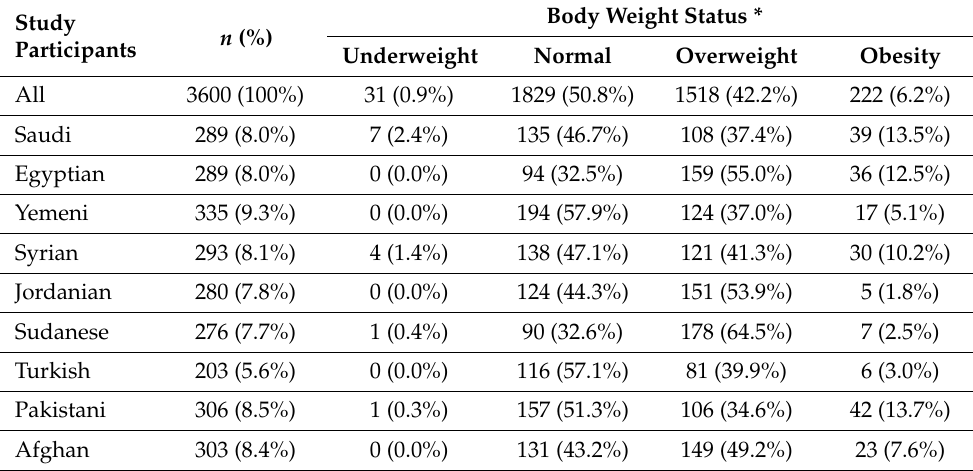
Figure 1. Bar chart illustrating mean body mass index for study participants from different countries. Bars labeled with different letters represent significantly different means ( p < 0.05) based on the Tukey post hoc test. Table 2. Overweight and obesity prevalence among study participants stratified by their